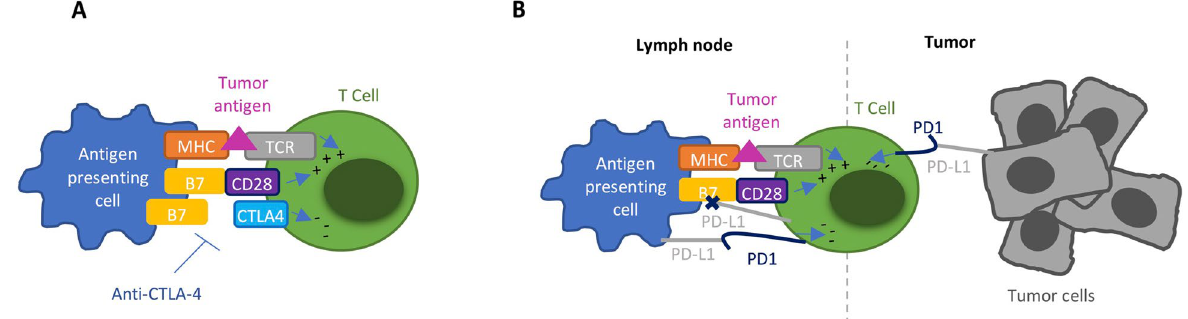
Fig. 1 Mechanism of action. A Tumor antigen presentation by the major histocompatibility complex (MHC) receptor and B7/CD28 costimulatory signal are both necessary for CD8 T-cell activation. CTLA-4 downregulates T-cell immune function. Anti-CTLA-4 antibodies inhibit this downregulation and stimulate the immune system. B Interaction between PD1 and PD-L1 takes place in the lymph node and in the tumor microenvironment. PD1 downregulates T-cell function as well. Trough PD-L1 binding PD1, tumors can escape immunosurveillance. Anti-PD-1 or -PD-L1 antibodies prohibit this and will restore the anti-tumor